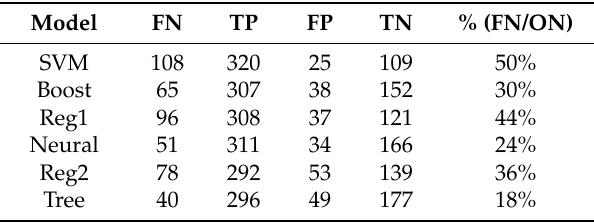
Table 8. Classification table—training sample.